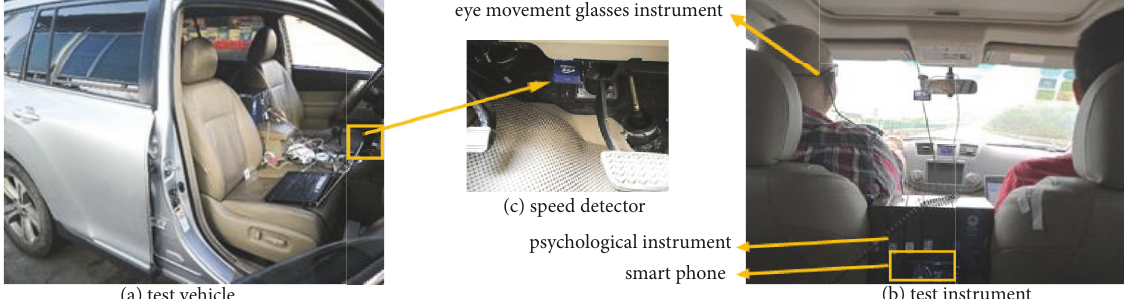
Figure 1: Vehicle and instruments used in naturalistic driving experiment. (a) Test vehicle, (b) test instruments, and (c) speed